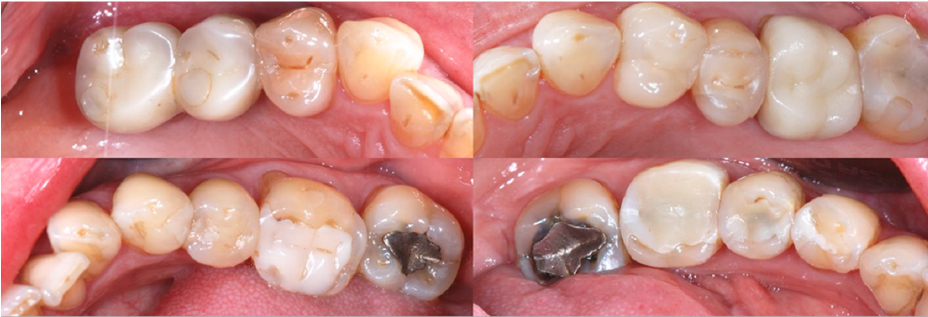
Figure 4. Pretreatment panoramic radiograph. Figure 5. Pre-treatment evaluations by endoral radiographs. 2.1. Therapeutic Plan In complex cases requiring an initial phase of pre-prosthetic orthodontics, it is useful to perform a set-up that, by simulating the outcome of orthodontic therapy, allows the dentist and orthodontist to plan together the final position of individual teeth and the distribution of spaces in the arches. Three-dimensional visualization of the result makes the treatment goals immediately understandable even to the patient, who can thus clearly understand the expected result and thus become more aware and cooperative. The shortcoming of the conventional orthodontic set-up is that it only visualizes the final position of the teeth without reference to other aspects that are fundamental to esthetic recovery, especially shape and color. Our contribution to solving this problem is drawn from the already well-known “three-step technique” of Vailati et al. [26–28], but differs from it in materials and operative protocols. The most significant feature consists in integrating the diagnostic